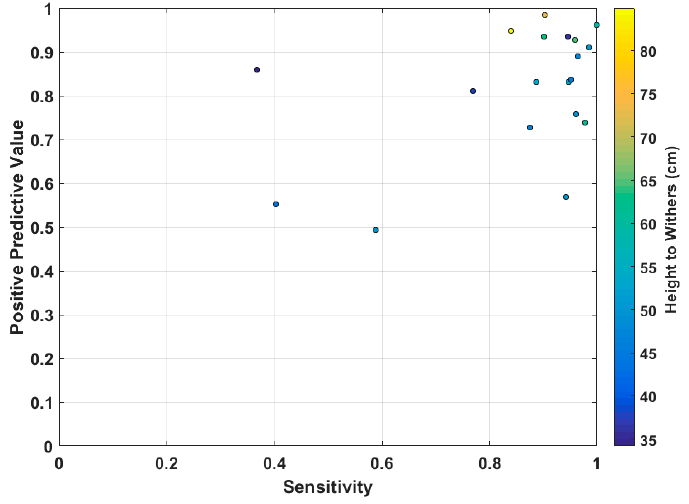
Figure 8. Results of PPV and Sensitivity calculations showing four outliers and no significant interaction between height and system performance.